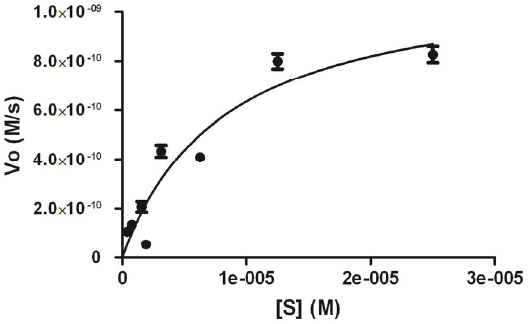
Figure 3. Representative Lineweaver-Burk analysis of MMP-2 and MMP-9 mediated proteolysis of 5FAM -THP. Enzyme kinetics were conducted by incubating activated 6 MMP-2 or -9 enzyme with varying concentrations (1-100 µM) of THP substrate. Initial velocities were obtained from plots of fluorescence with respect to time using only the linear portion of the data. Relative fluorescence units were converted from known values were determined by non-linear concentrations of 5FAM in assay buffer. K M regression and fit with GraphPad Prism. Error bars are contained within the